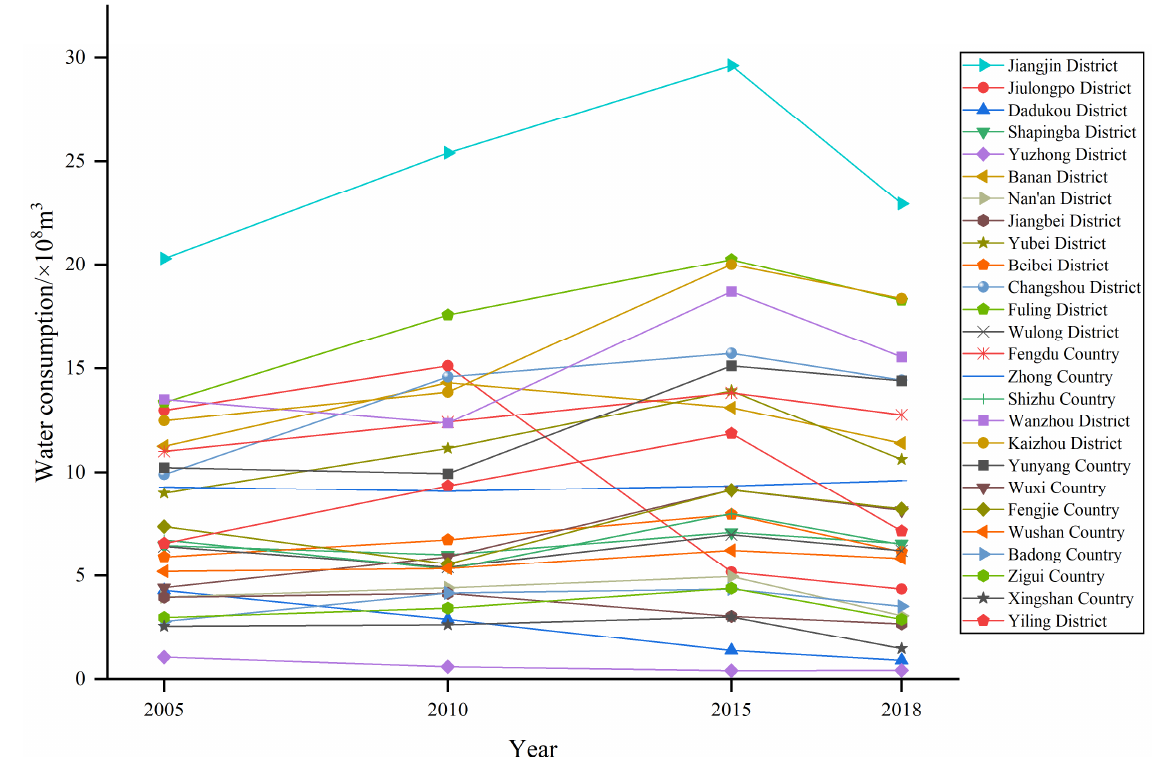
Figure 11. Water consumption by districts and counties in the Three Gorges Reservoir Area from 2005 to 2018.